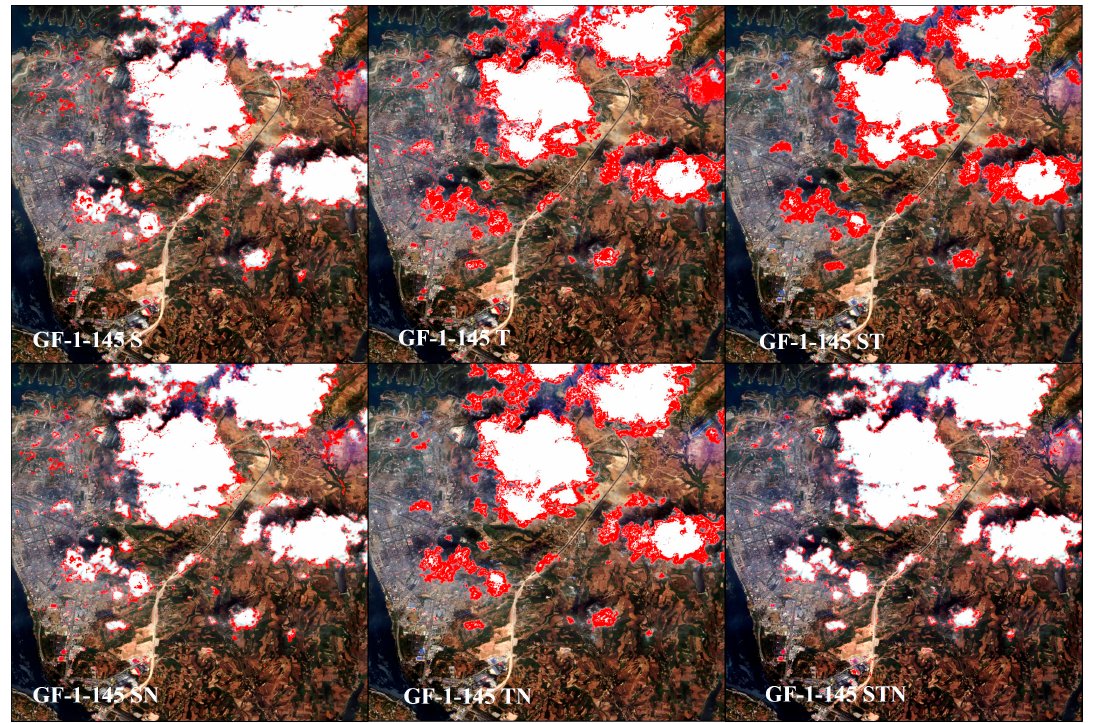
Figure 11. The partial enlarged view of total classification error results in cloud detection for Spectra (S), Texture (T), Spectra + Texture (ST), Spectra + NDVI (SN), Texture + NDVI (TN), and Spectra + Texture + NDVI (STN) feature fusion on GF-1-145 images (red regions in the picture represent total classification error results in cloud detection).